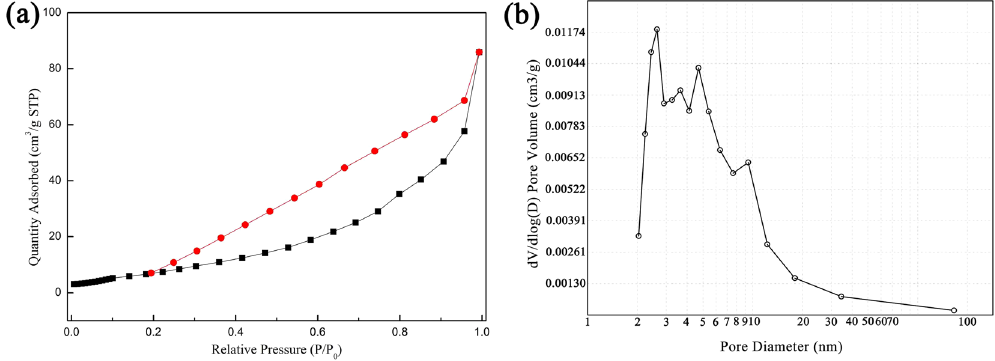
Figure 6. Nitrogen adsorption–desorption isotherms collected at 77 K: ( a ) Porous MoO 3 synthesized at 400 °C, ( b ) Pore size distribution curves.